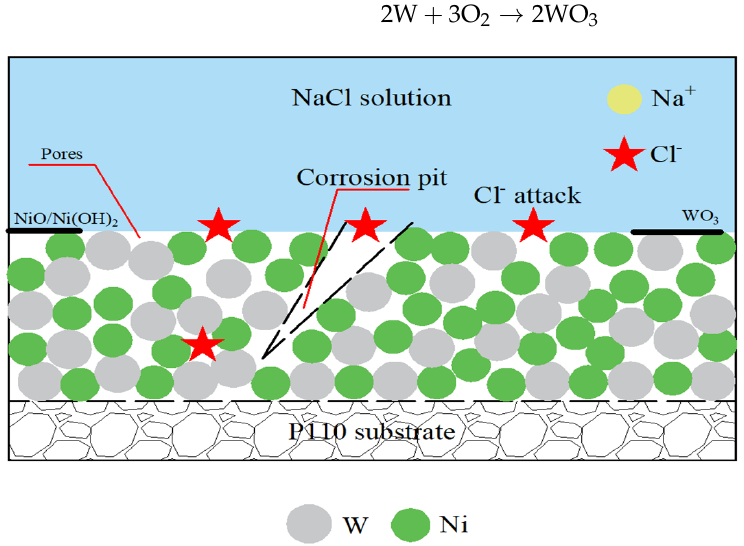
Figure 10. Schematic diagram of corrosion process of Ni-W coating in 3.5% NaCl solution.